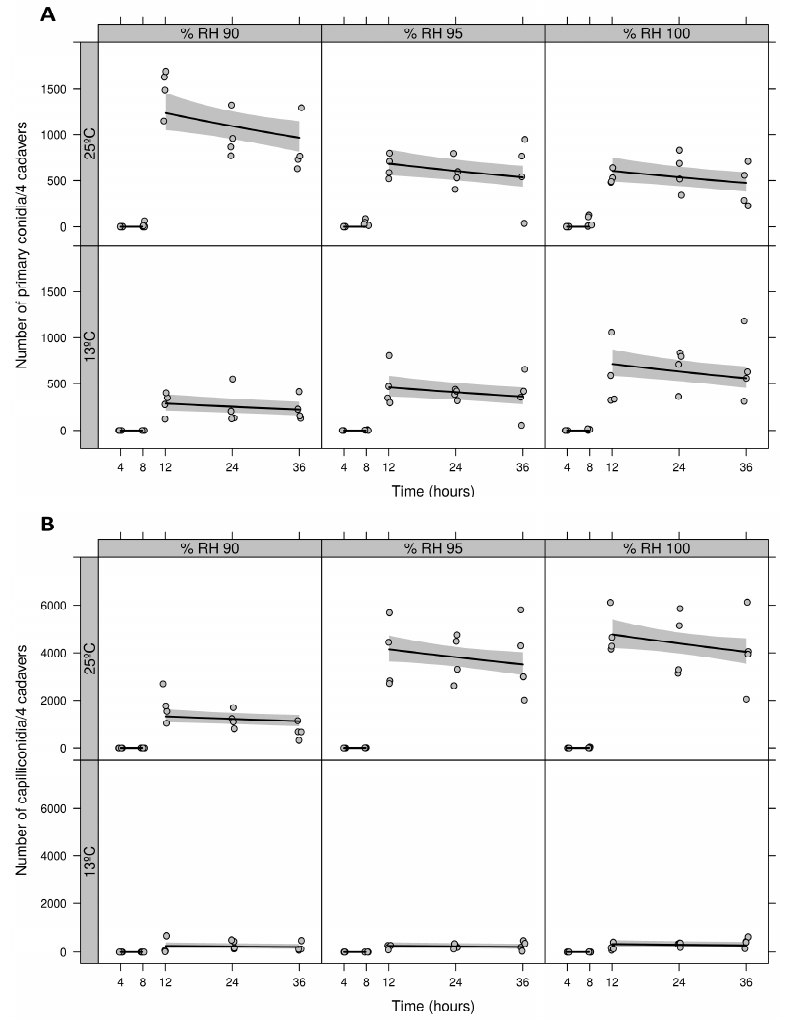
Figure 3. Effect of time (4, 8, 12, 24 or 36 h) on primary conidia production ( A ) and capilliconidia formation ( B ) by a Brazilian Neozygites floridana isolate (ESALQ 1420) at three different RHs (90, 95, 100%) and two temperatures (13, 25 °C).